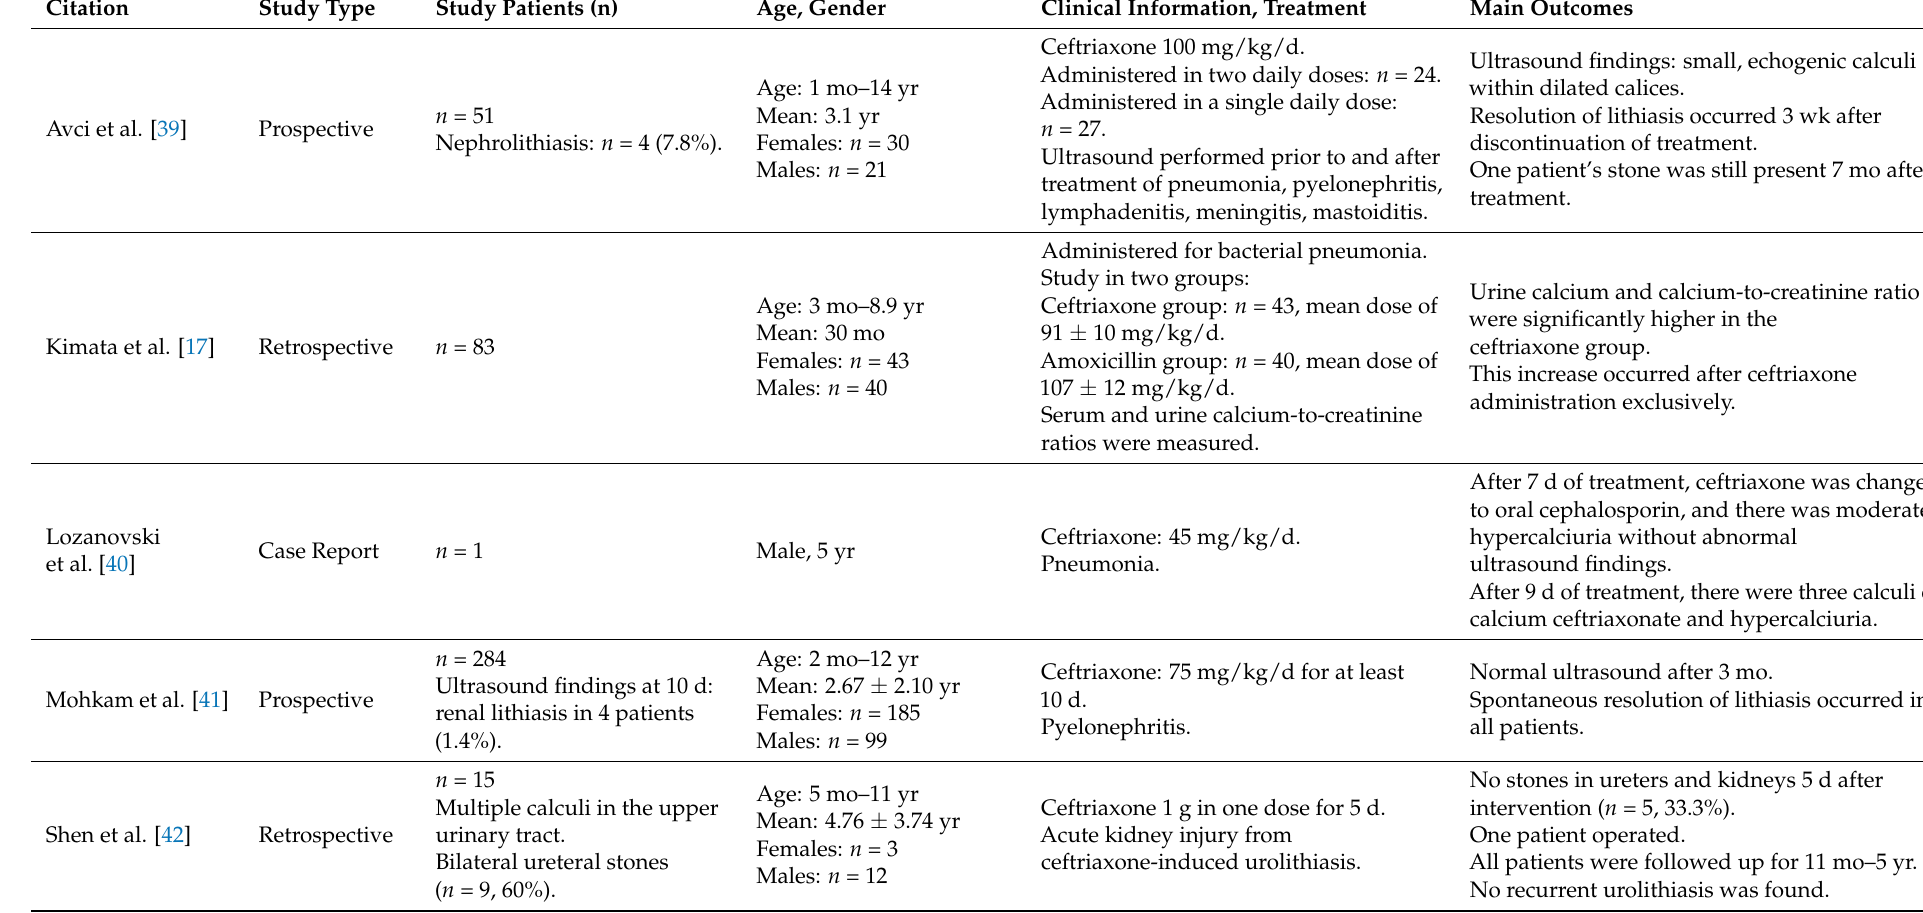
Table 2. Summary of the main findings from the articles included in the study for exclusively urinary tract ceftriaxone-related